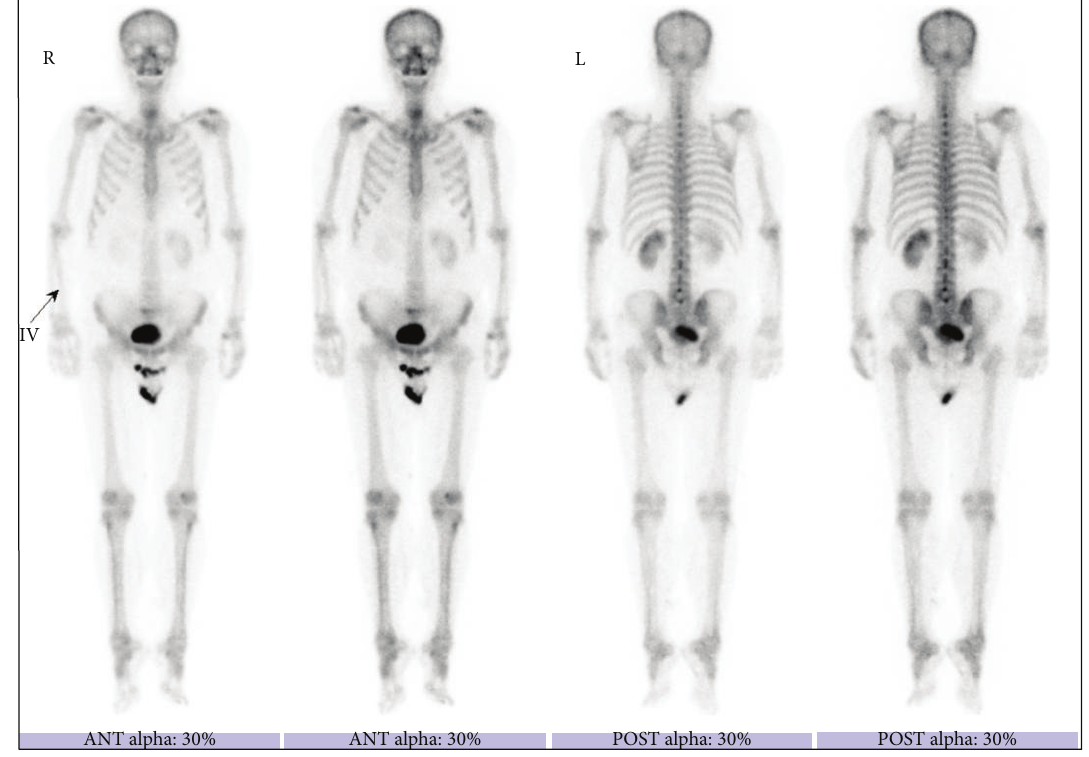
Figure 5: Bone scintigraphy performed after surgery shows no intense uptake suggesting bone metastasis.